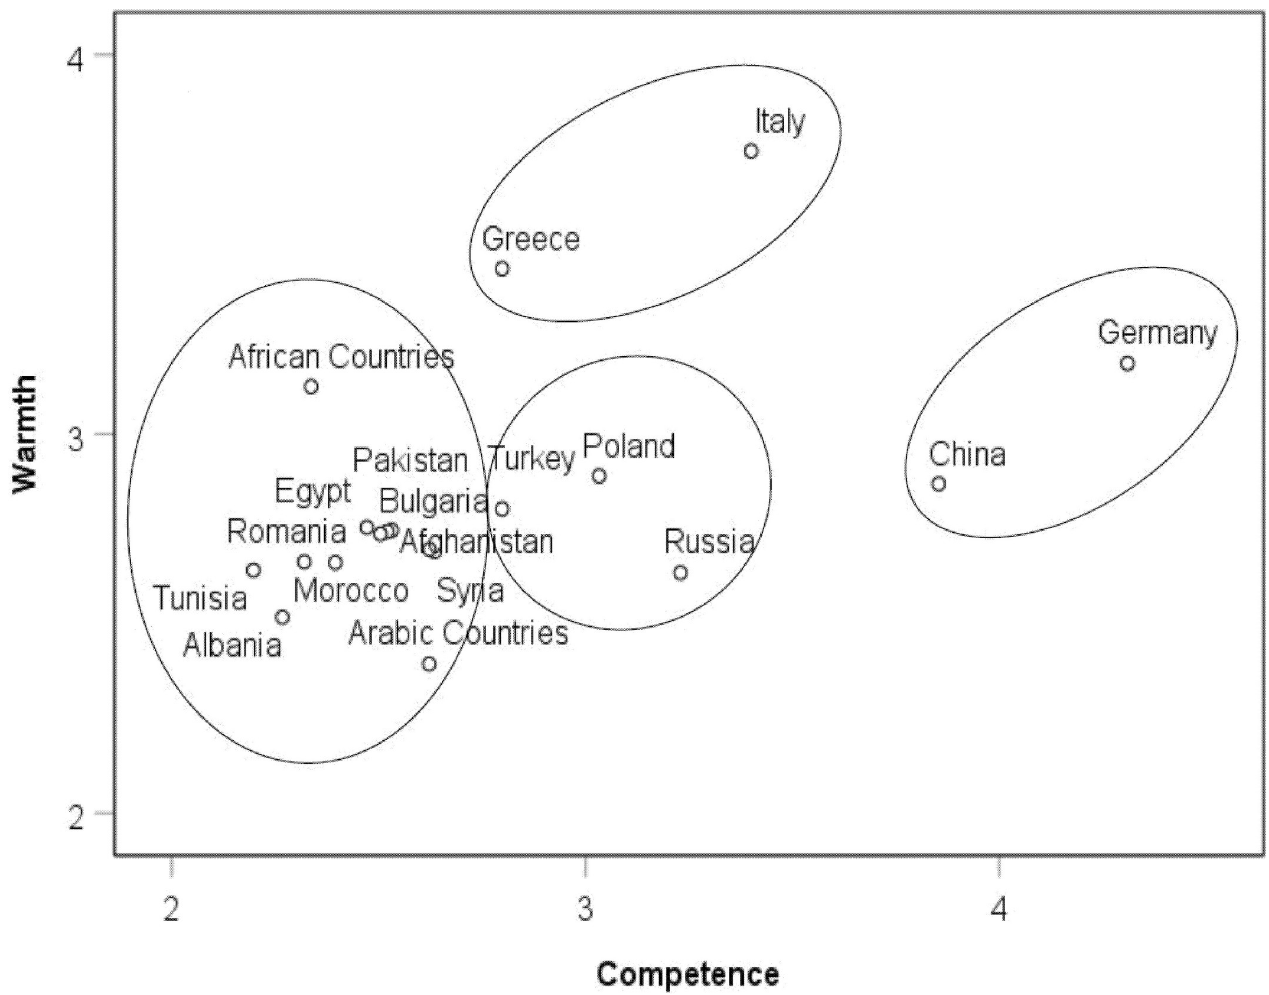
Fig 1. Warmth by competence space mapping the clusters of immigrant groups ( N = 18).